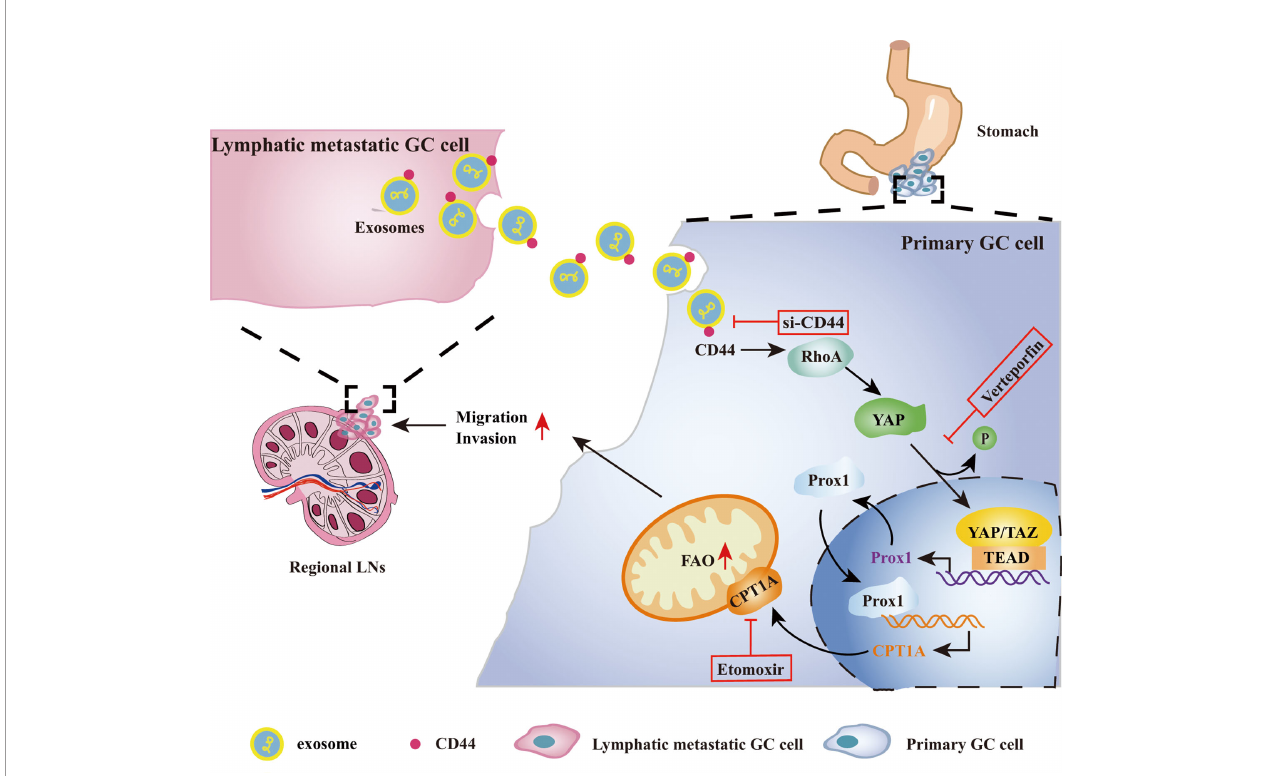
FIGURE 7 | Schematic overview showing lymphatic metastatic GC cell-exosomal CD44 increases FAO to confer LNM phenotype on primary GC cells via the RhoA/ YAP/CPT1A signaling axis. Metastatic GC cells in LNs secrete CD44-rich exosomes, which are taken up by GC cells in primary GC tissues and upregulate its intracellular CD44 protein. CD44 then increases RhoA expression, stimulates YAP expression, de-phosphorylation and nuclear translocation. YAP and TAZ function as transcriptional co-factors to promote Prox1 transcription and protein generation. Prox1 further translocates into nuclei and increases CPT1A transcription. CPT1A protein upregulation promotes FAO reprogramming and increases cell migration and invasion, leading to acquiring LNM capacity by primary GC cells. CD44, YAP and CPT1A might be potential therapeutic targets to suppress exosome-mediated LNM phenotype transfer from lymphatic metastatic GC cells to primary GC cells. LNs, lymph